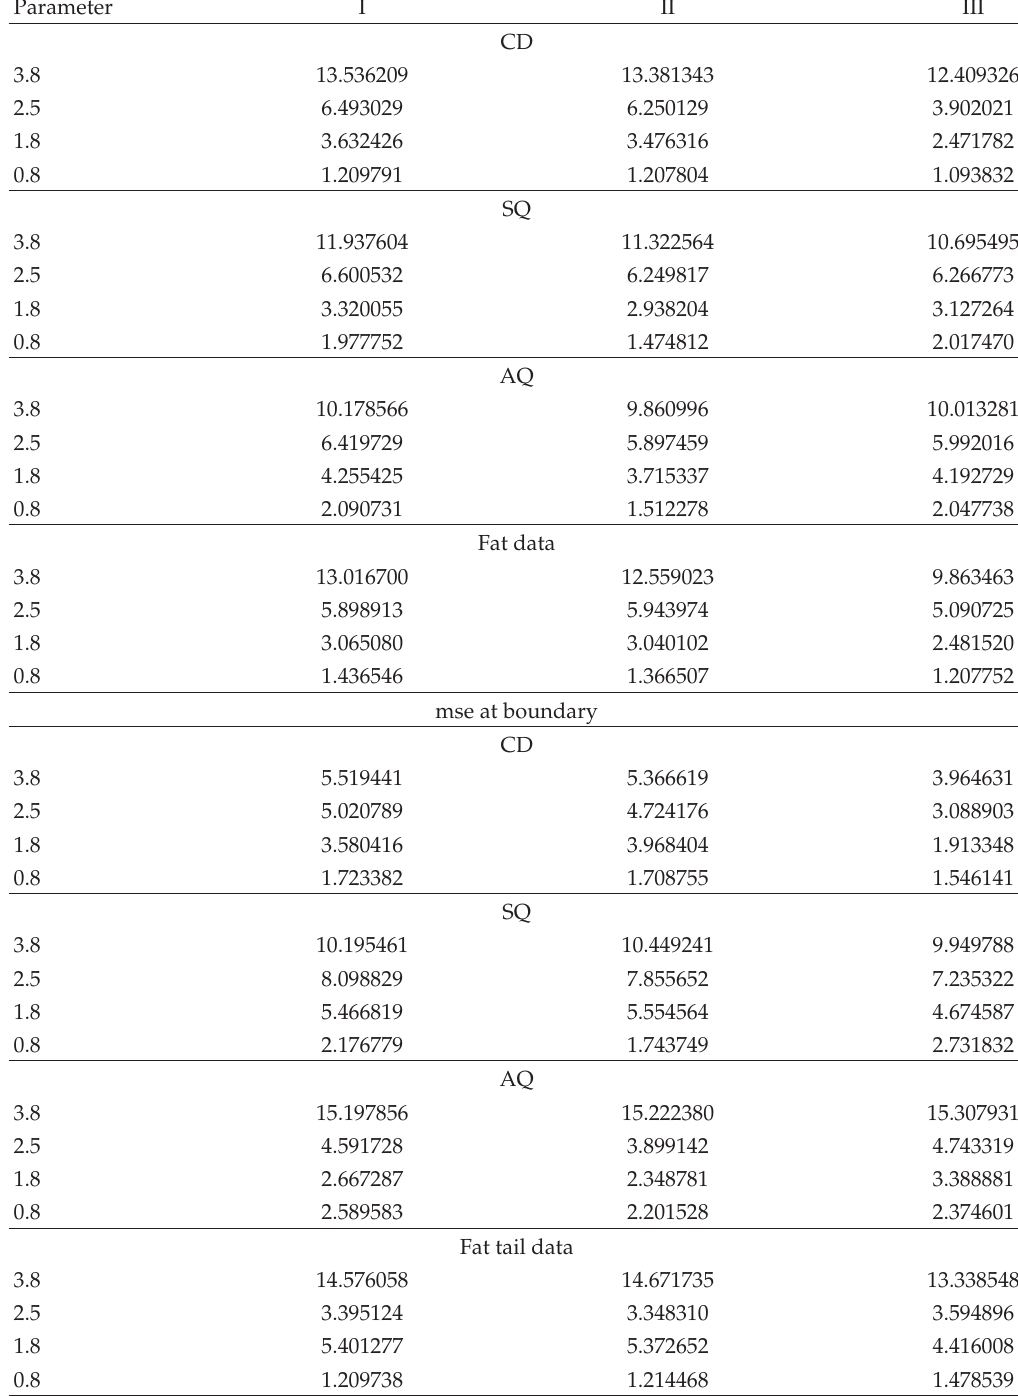
Table 5: Simulation results of global and mean squared using MA (cid:5) 1 (cid:6) with di ff erent parameters. The first half of the table displays the global mean squared